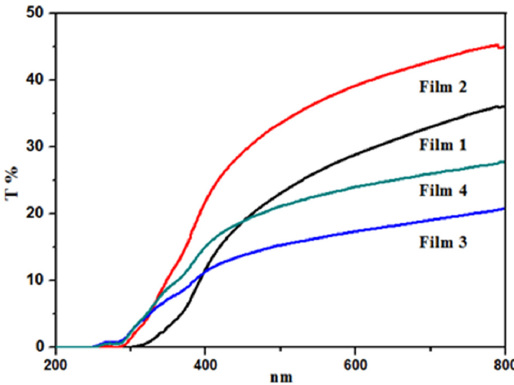
Figure 8. UV ‐ Vis spectra of blend Film 1, Film 2, Film 3, and Film 4.